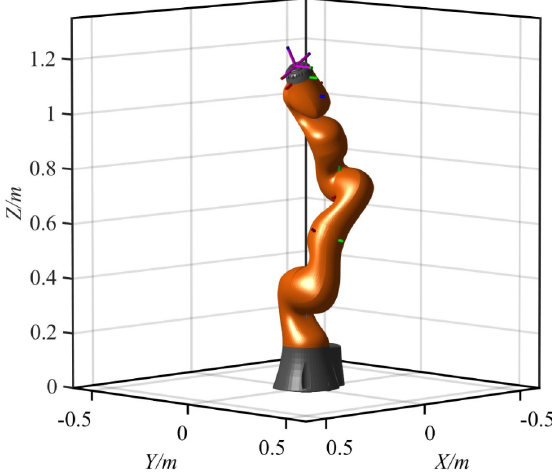
Figure 13. Initial position of iiwa